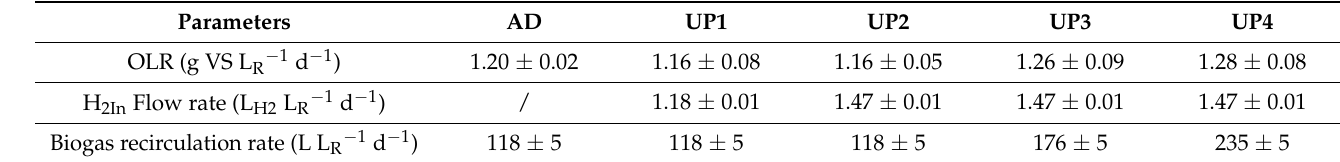
Table 2. Scheme of the different experimental